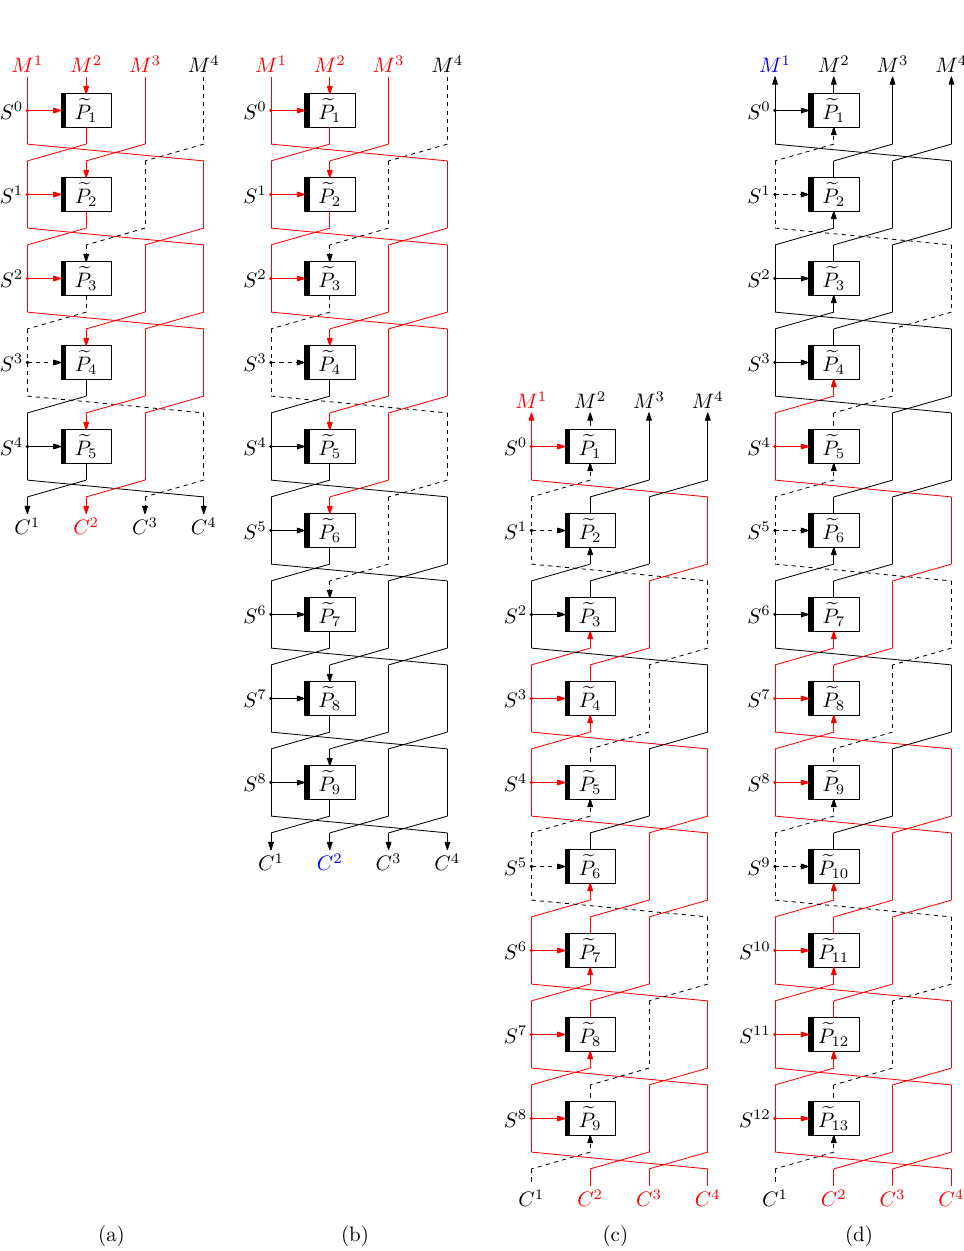
Figure 14: Examples of our attacks against TBC-based type-1 GFS with d = 4 (red: zero difference, dashed: non-zero difference, black: random difference, blue text: the target for finding a collision). (a) The constant CPA with q = 2 for r = 2 d − 3 = 5. (b) The birthday CPA with q = 2 n/ 2 for r = 3 d − 3 = 9. (c) The constant CCA with q = 2 for r = d 2 − 2 d + 1 = 9. (d) The birthday CCA with q = 2 n/ 2 for r = d 2 − d + 1 =